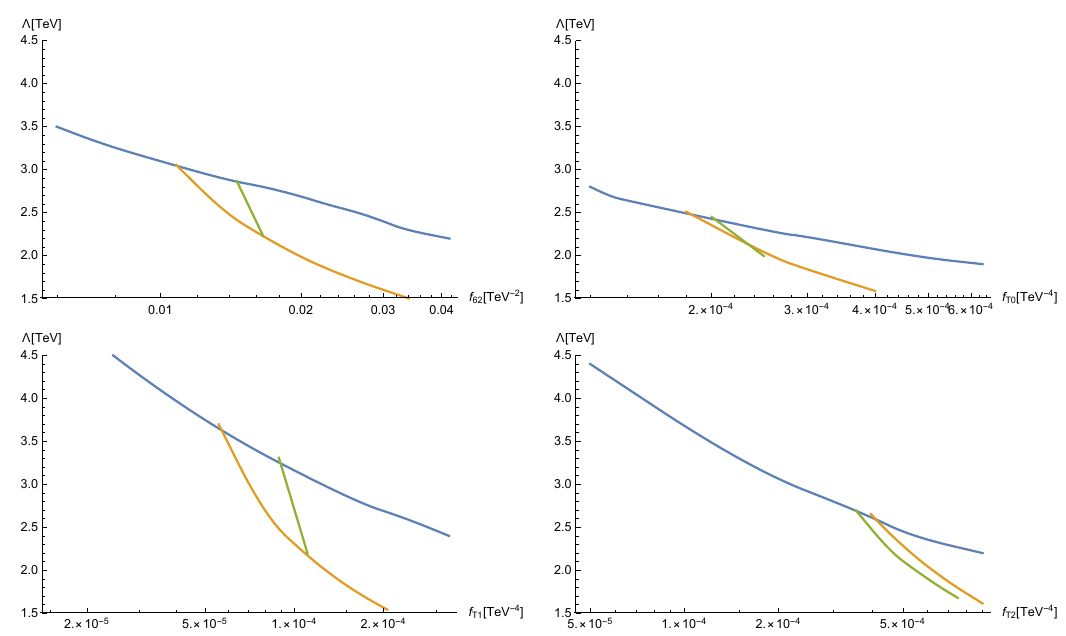
Figure 3 . Same description as in (cid:12)gure 2. From top to bottom and from left to right, the operators considered are T